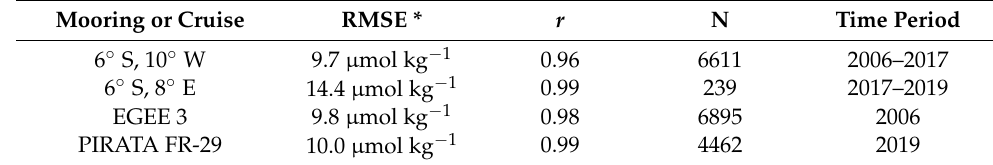
Table 2. Comparison between the DIC predicted by Equation (3) and DIC calculated from measured fCO 2 and alkalinity from Equation (2). The statistics include the Root Mean Squared Error (RMSE), the correlation coefficient ( r ) and the number of data (N). The data of the moorings correspond to daily means. * RMSE using the coefficients of Equation (3) with all decimal places are calculated in Appendix A.